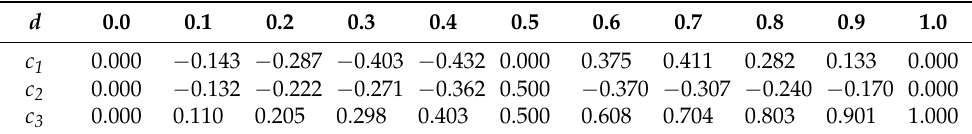
Figure 6. Fitting diagram of noise SD and weight coefficient a :,d : ( a ) a :, 0.1 ; ( b ) a :, 0.2 . Table 1. Coefficient for a :,d